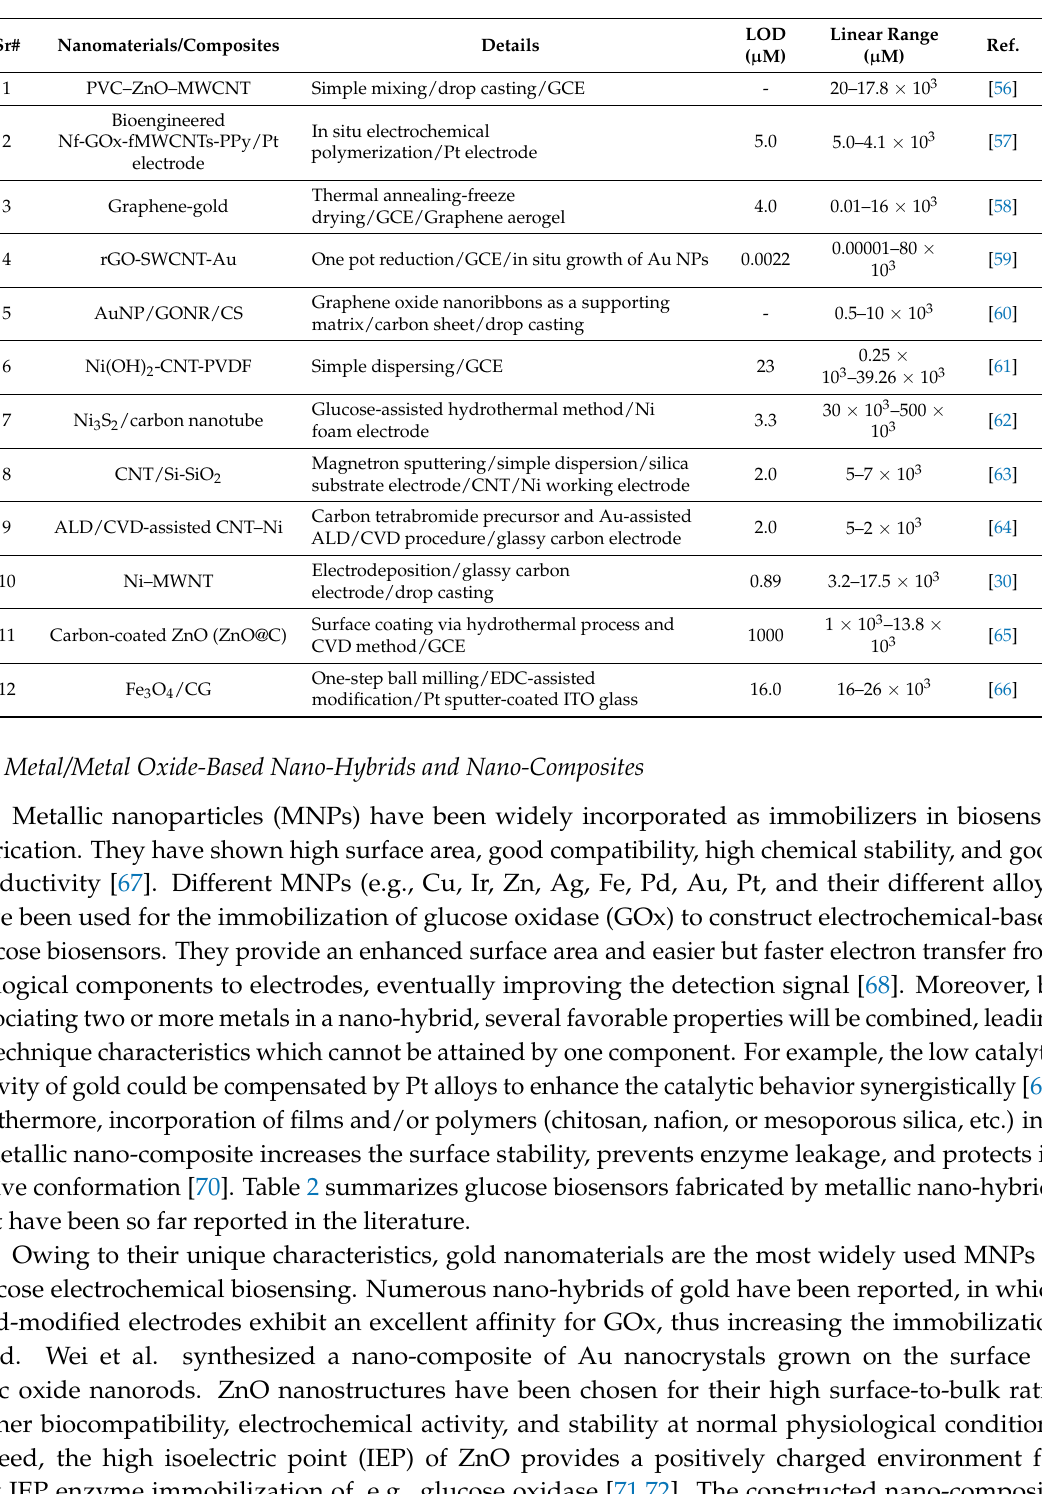
Table 1. Carbon material-based nano-hybrids and nano-composites for the electrochemical detection of